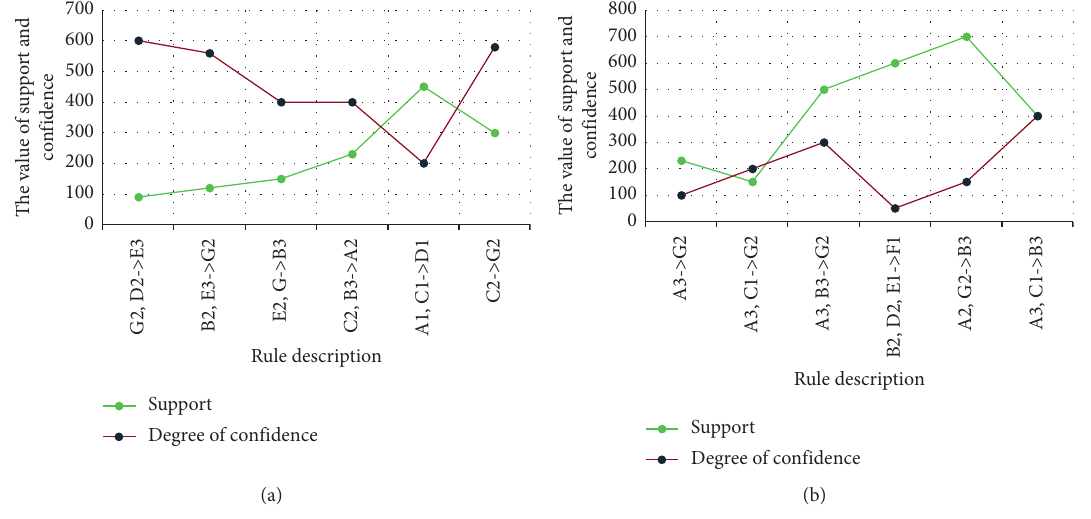
Figure 7: Analysis of the results of algorithm mining of association